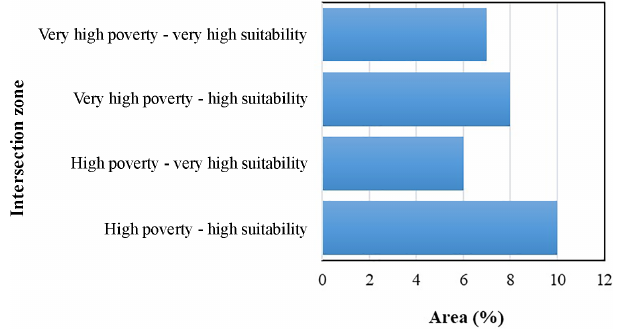
Figure 10. Area percentages of the four intersection zones.